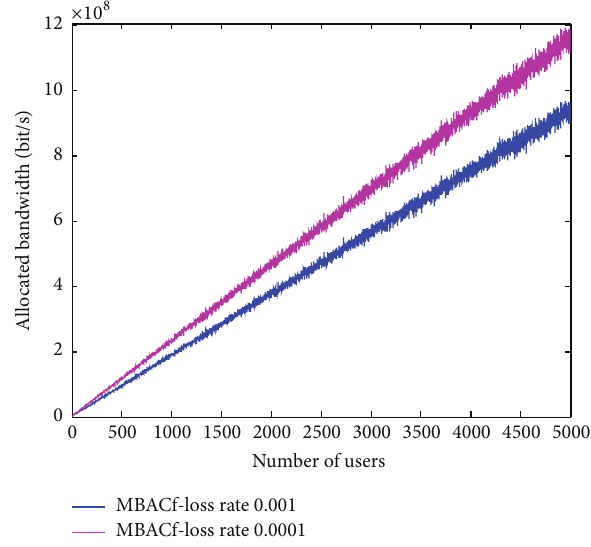
Figure 9: Allocating of bandwidth for the growing number of users for different loss rates in the